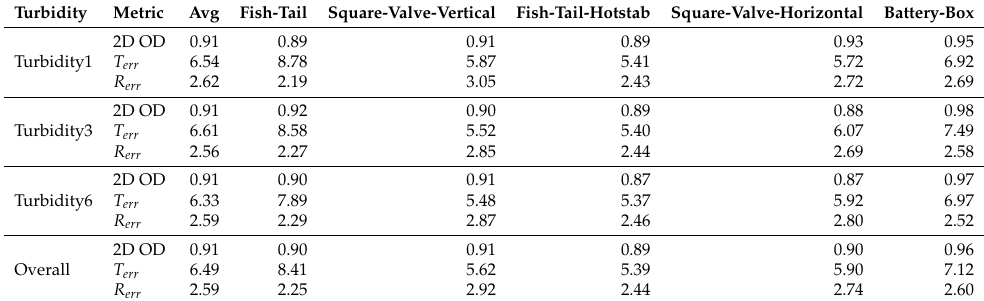
Table 1. 6D pose and 2D object detection performance. The 2D object detection (2D OD) is measured in average precision (AP). The translation and rotation errors (RTE, RRE) are represented in cm and degree ( ◦ ),